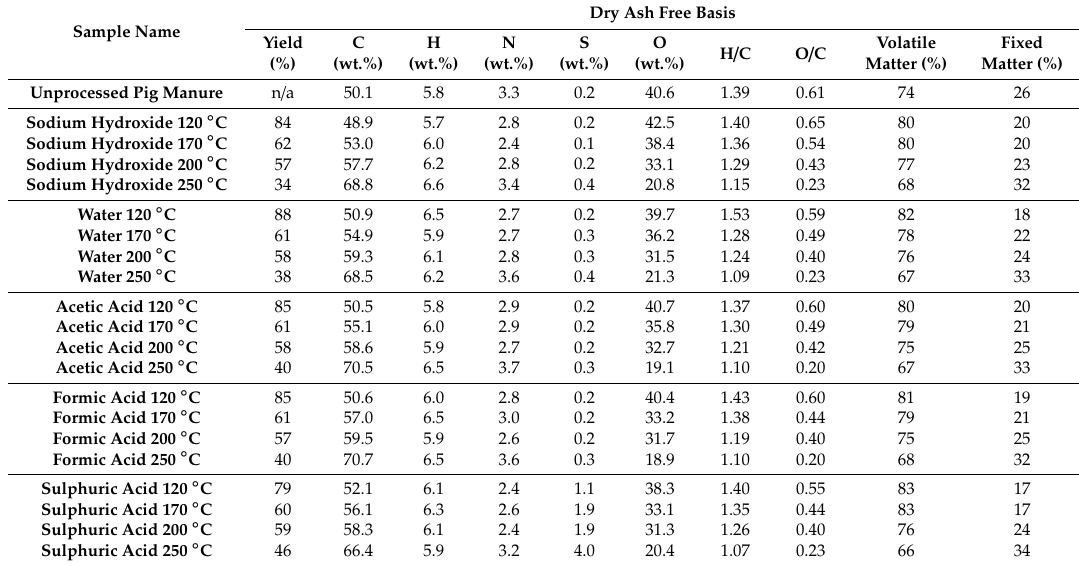
Table 3. Ultimate analysis proximate analysis and yields of fuels on a dry ash free basis.